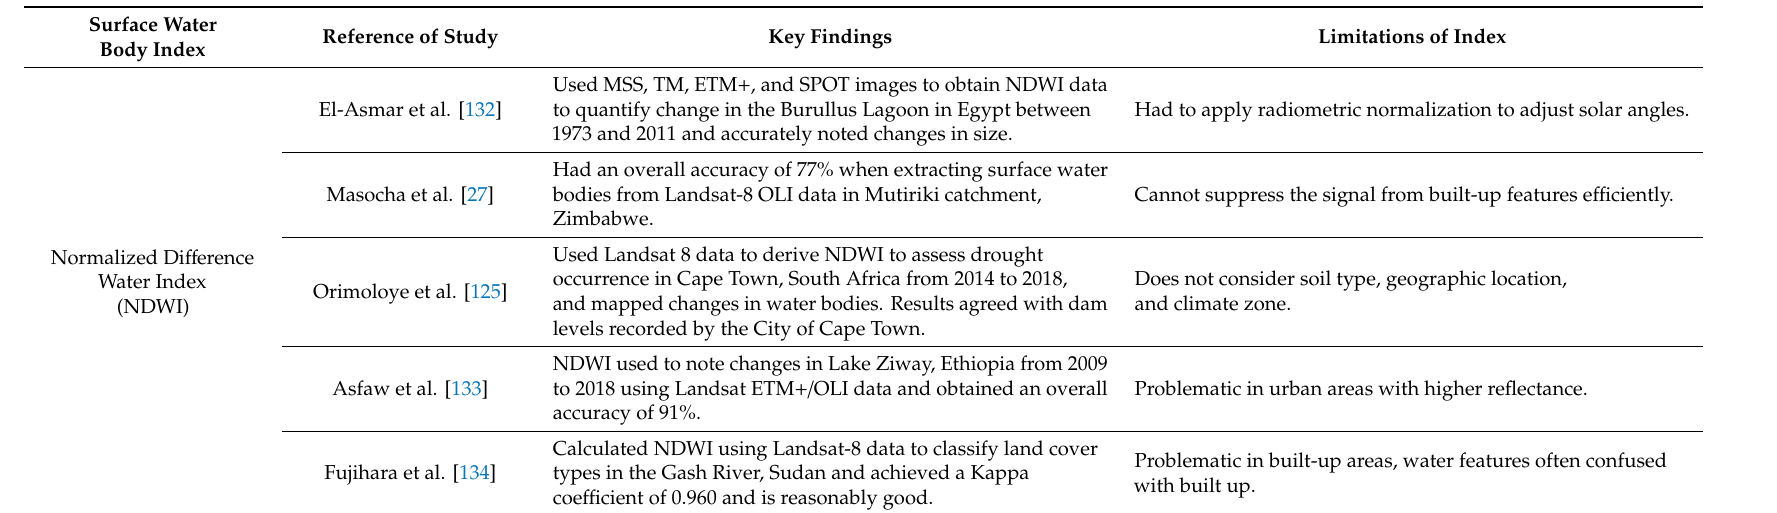
Table 4. Surface water body indices used and their performance in previous